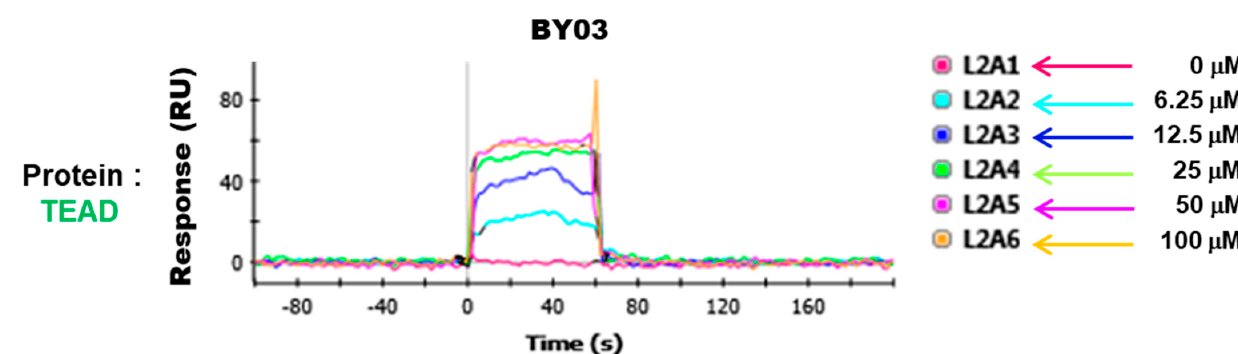
Figure 8. SPR analysis of BY03 to TEAD1. Sensorgrams of BY03 binding to the TEAD1. In the SPR experiment, TEAD1 was immobilized onto the vertical channels of a NeutrAvidin-precoated ProteOn GLH sensor chip, and BY03 was injected into the horizontal channels of the sensor chip at different concentrations of 0, 6.25, 12.5, 25, 50, and 100 μ M.